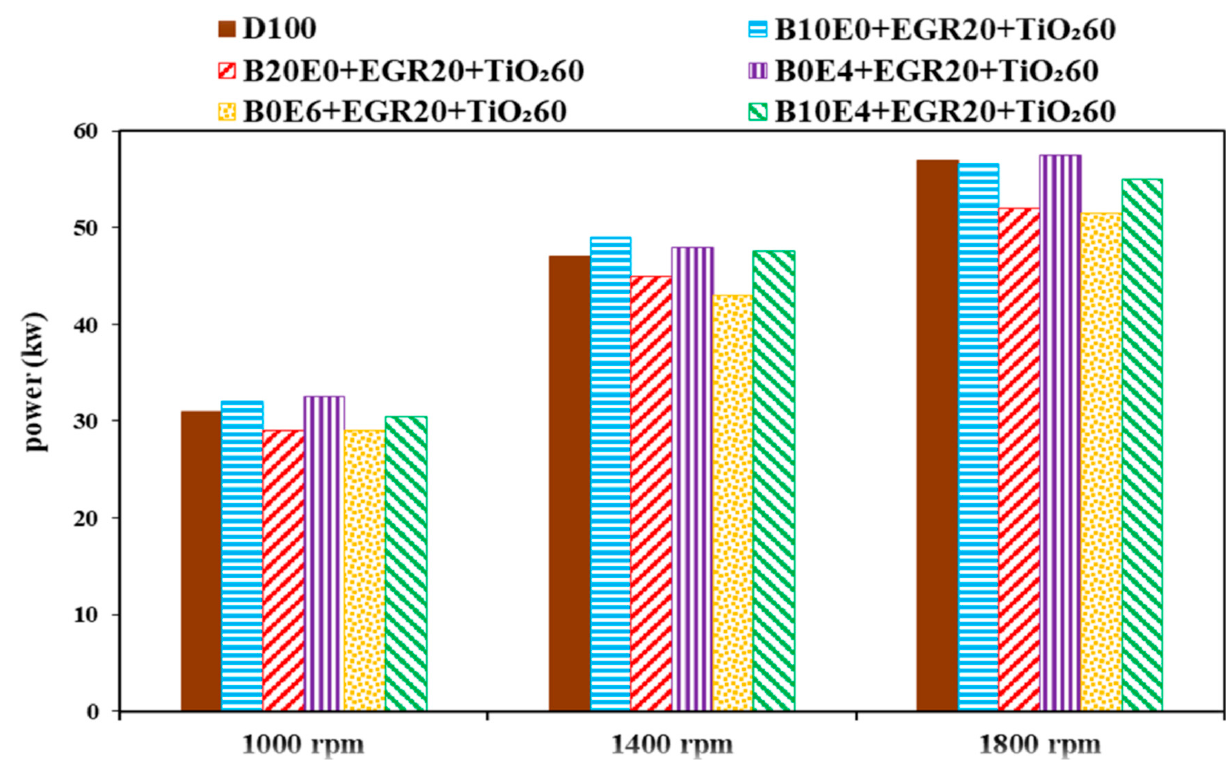
Figure 3. Variation of power for diesel/ethanol/biodiesel blends at EGR = 20%, TiO 2 = 60 ppm, and various engine speeds.